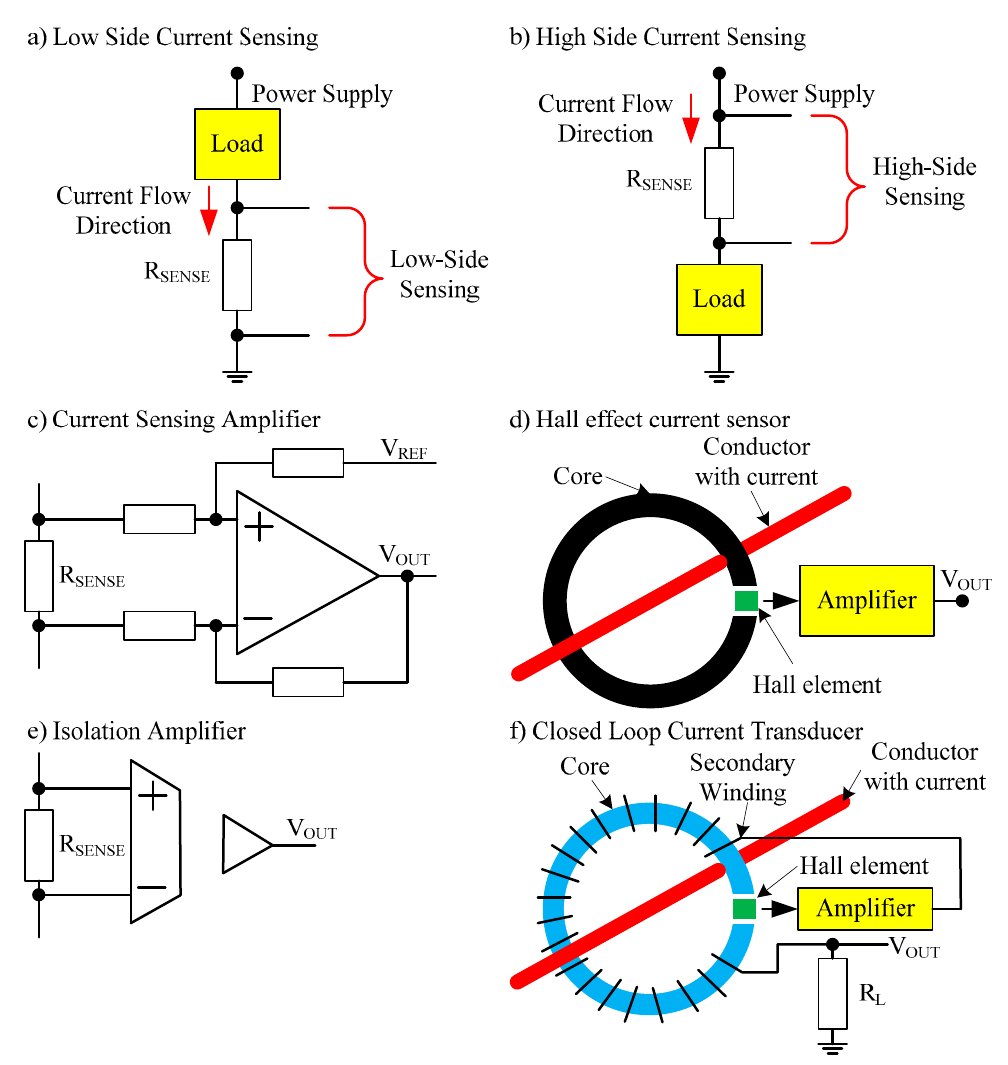
Figure 1. Methods for current measurement.